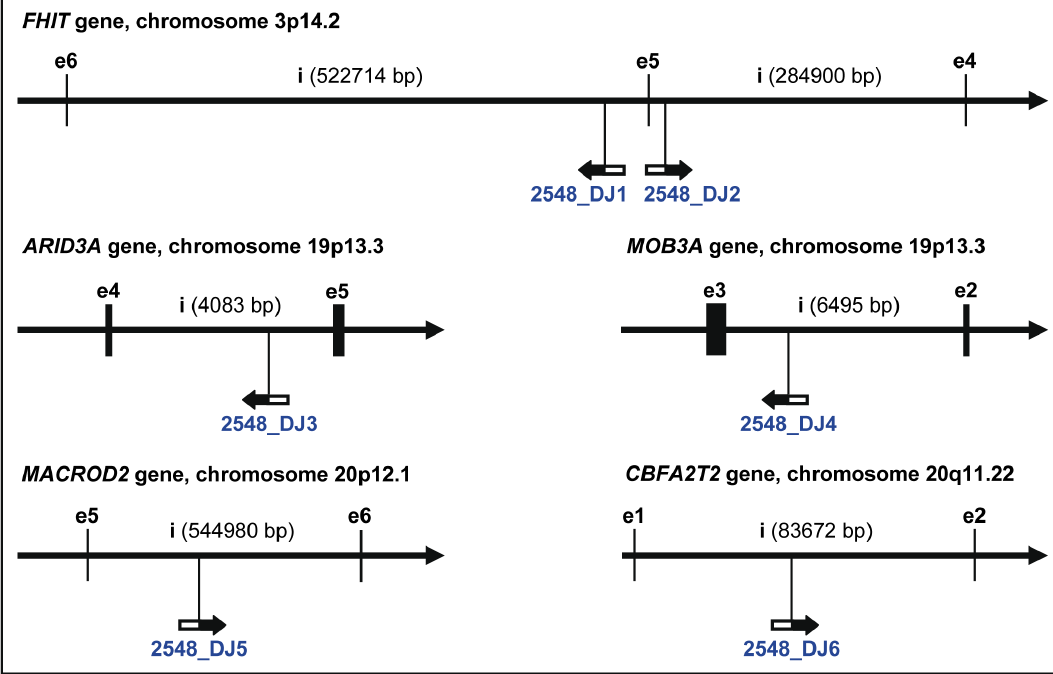
Figure 6. Tumor T2548 with six HPV16 DNA integration sites. The six integration sites are distributed on the chromosomes 3, 19 and 20 (two DJs on each). All six integration sites are intragenic, but none of them is transcriptionally active. The cellular genes directly targeted by HPV16 DNA integration in T2548 include FHIT (transcript 002, Ensembl ID: ENST00000468189, minus strand, 9 exons), ARID3A (transcript 001, Ensembl ID: ENST00000263620, plus strand, 9 exons), MOB3A (transcript 001, Ensembl ID: ENST00000357066, minus strand, 5 exons), MACROD2 (transcript 010, Ensembl ID: ENST00000217246, plus strand, 17 exons) and CBFA2T2 (transcript 003, Ensembl ID: ENST00000375279, plus strand, 12 exons).